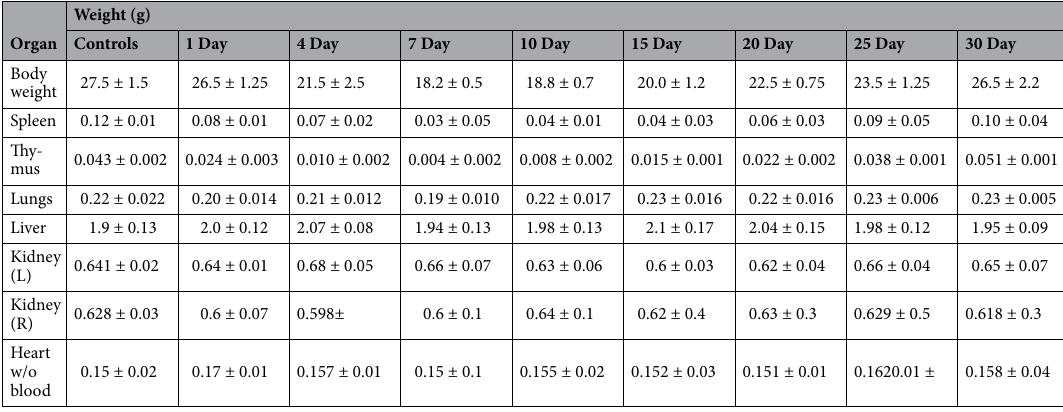
Table 1. Different organ weight of mice exposed to 15 Gy of localized radiation at various time